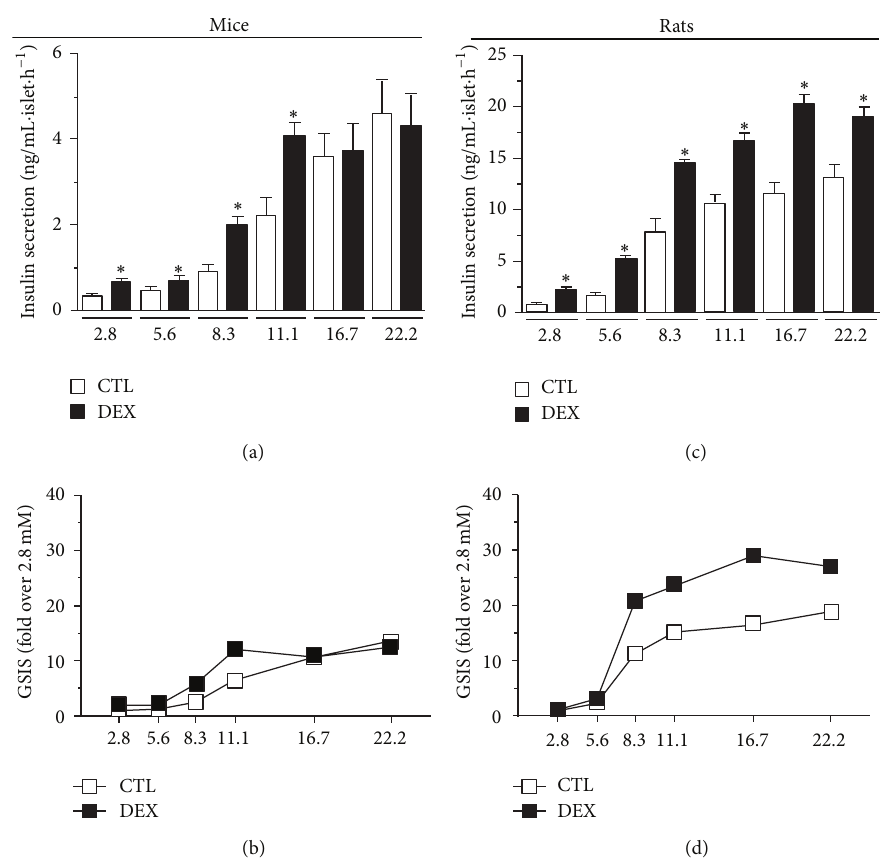
Figure 2: Islets from DEX-treated rats are more responsive to glucose than islets from DEX-treated mice. ((a), (c)) Static cumulative insulin secretion in isolated islets from DEX-treated mice and rats in response to different glucose concentrations, respectively. ((b), (d)) Normalized glucose-stimulated insulin secretion (GSIS) (fold increase in relation to 2.8 mmol/L glucose) in mice and in rats, respectively. Values are mean ± S.E.M.; 𝑛 = 4–6 wells from 5 different animals. ∗ Significantly different compared to CTL. Unpaired Student’s 𝑡 -test, 𝑃 ≤ 0